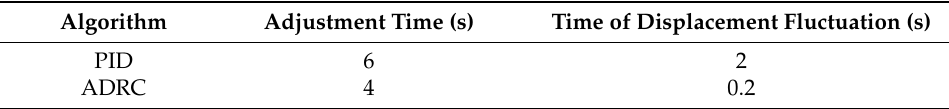
Table 2. Time domain index under step